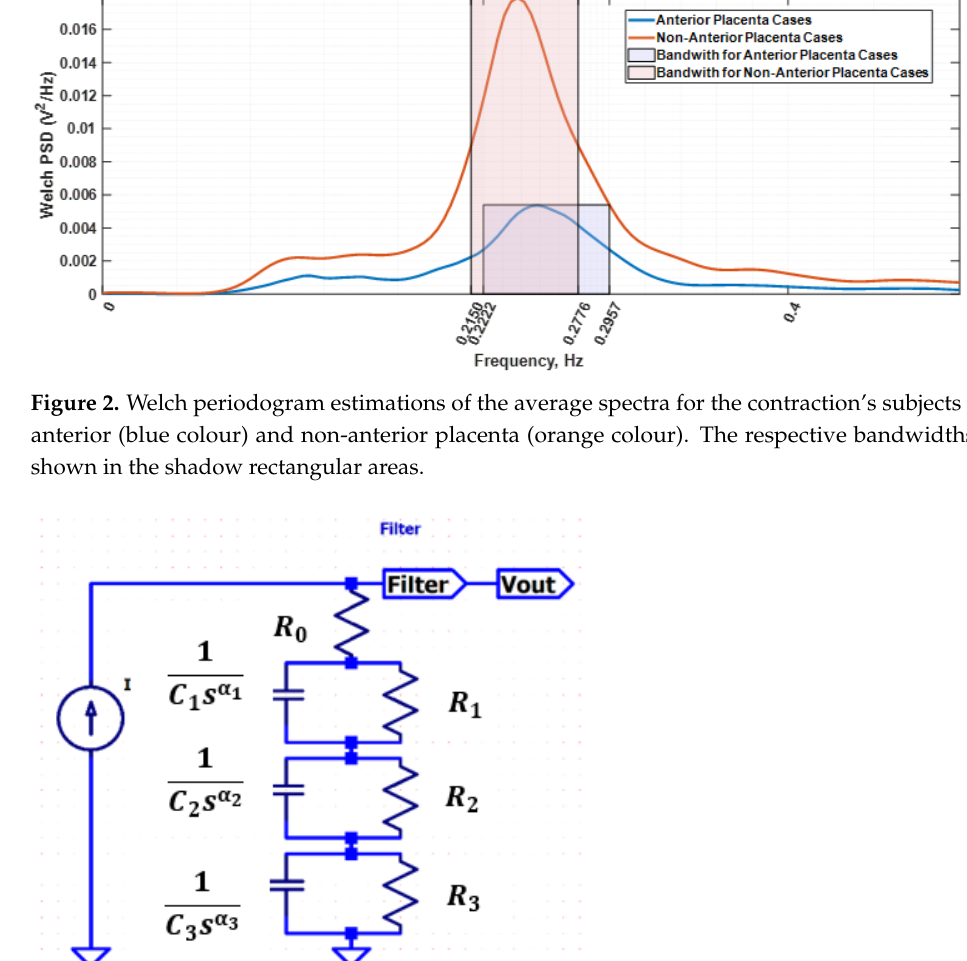
Figure 3. Proposed triple-dispersion Cole model. The filter, F , accounts for the used filter for pro- cessing the automatically detected contractions [48].